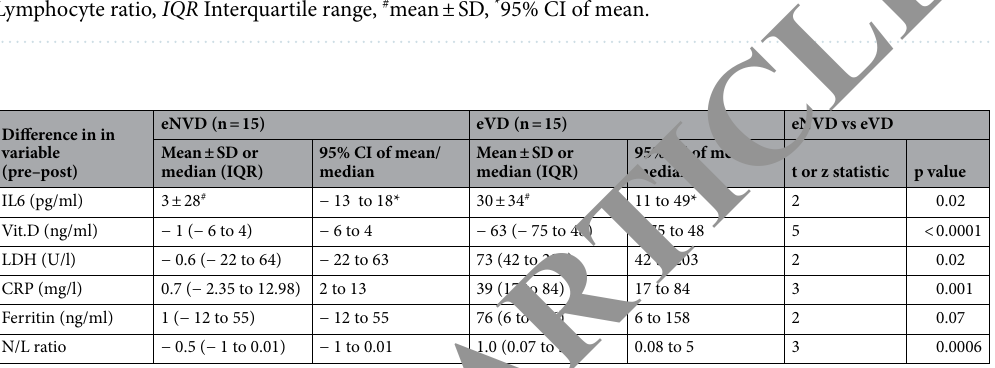
Table 6. Values of difference in the inflammatory markers and vitamin D between the sub groups (eNVD vs eVD). Vit.D Vitamin D, CRP C-reactive protein, LDH Lactate dehydrogenase, Il-6 Interleukin-6, N/L ratio